Question: What kind of plot is shown here?
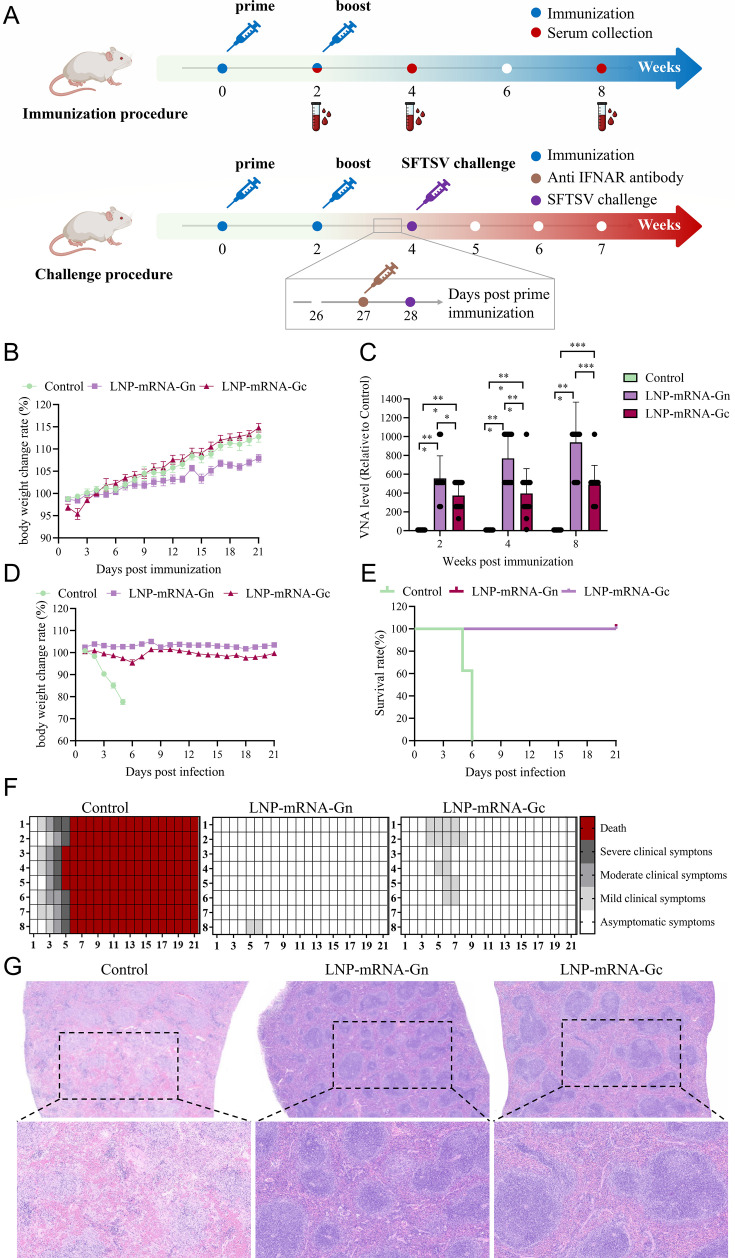
Answer: survival